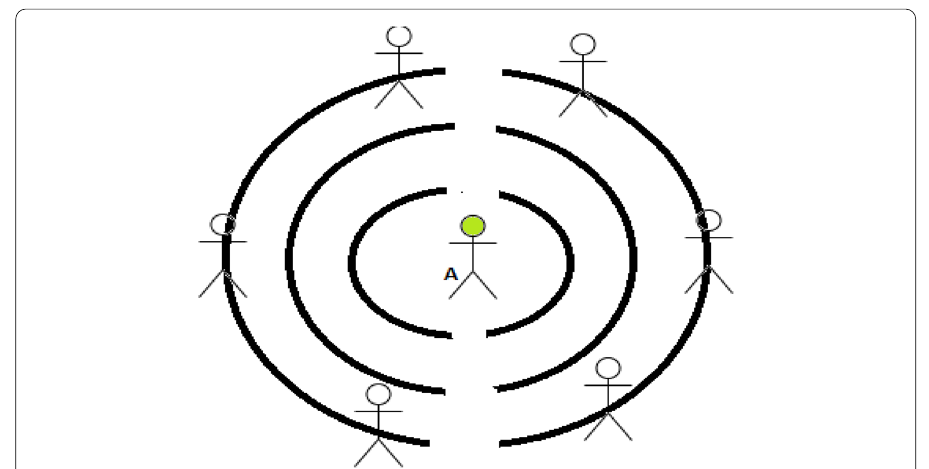
Fig. 4 Working principle of wristband with PIR